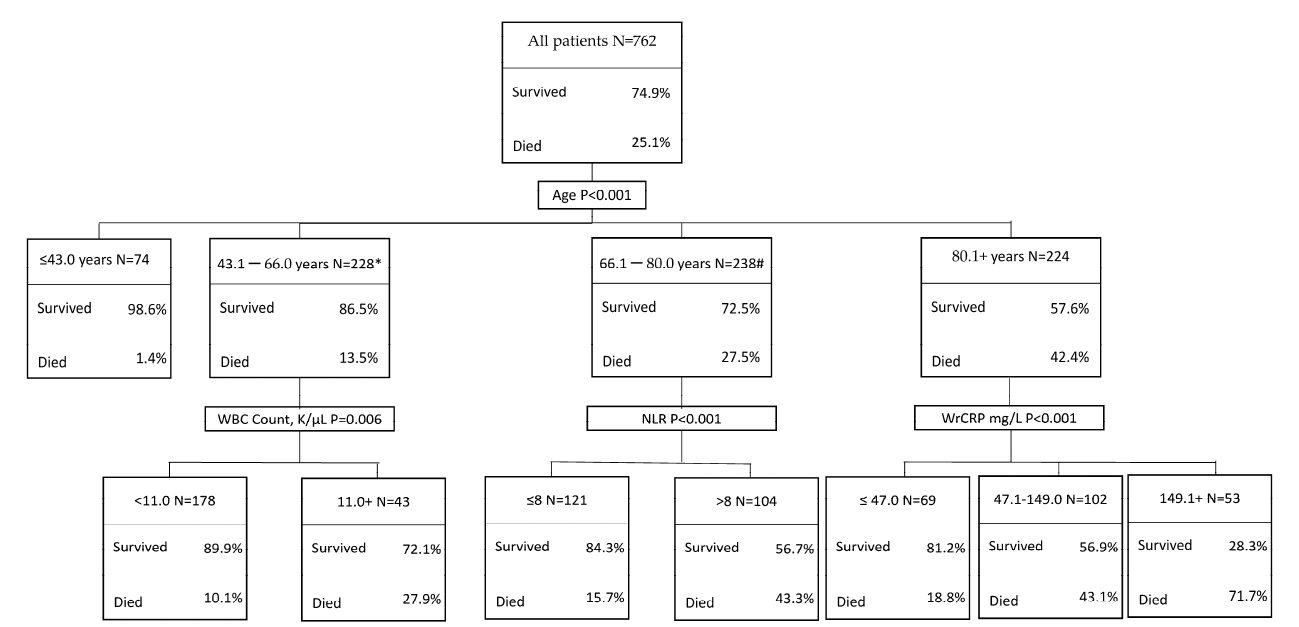
Figure 2. Classification tree using the CHAID methodology showing the association between in- hospital mortality and WBC, NLR, and CRP in subgroups of patients. * 7 patients had missing CBC count, # 11 patients had missing CBC count.